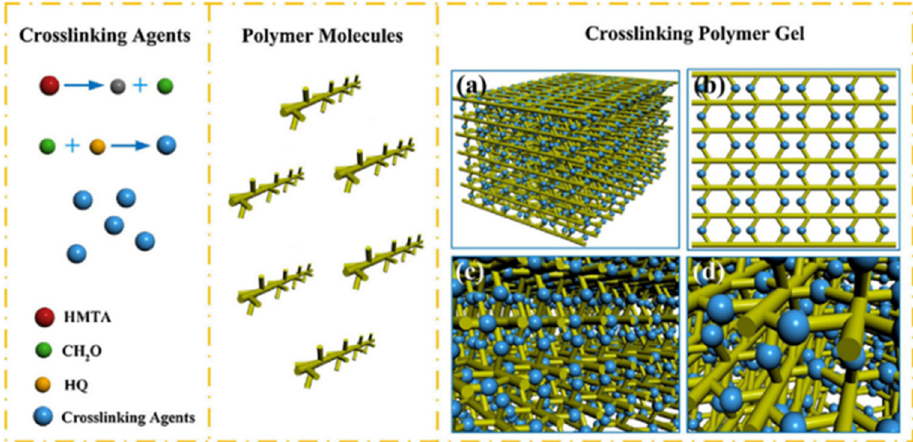
Figure 5. Crosslinking mechanism of HQ/HMTA. ( a – d ) Three-dimensional network structure of gels from different perspectives. (Reprinted/adapted with permission from Ref. [40], 2016, Liu et al.).